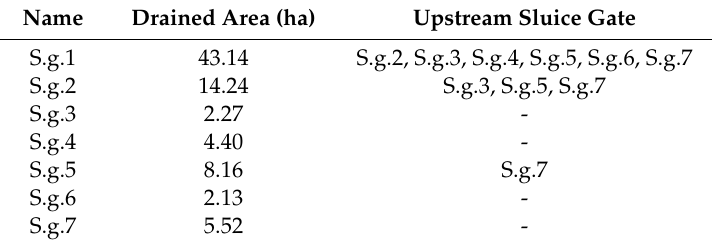
Table 2. Characteristics of the sub-basins controlled by each sluice gate.